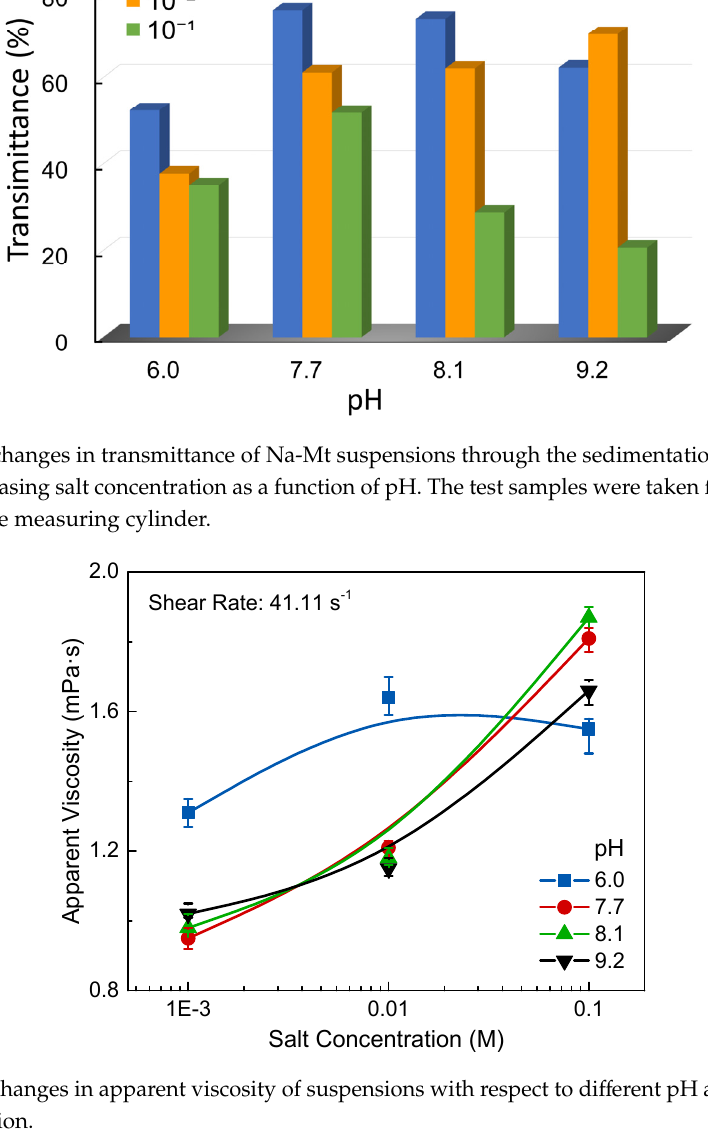
Figure 9. The changes in apparent viscosity of suspensions with respect to different pH as a function of salt concentration.